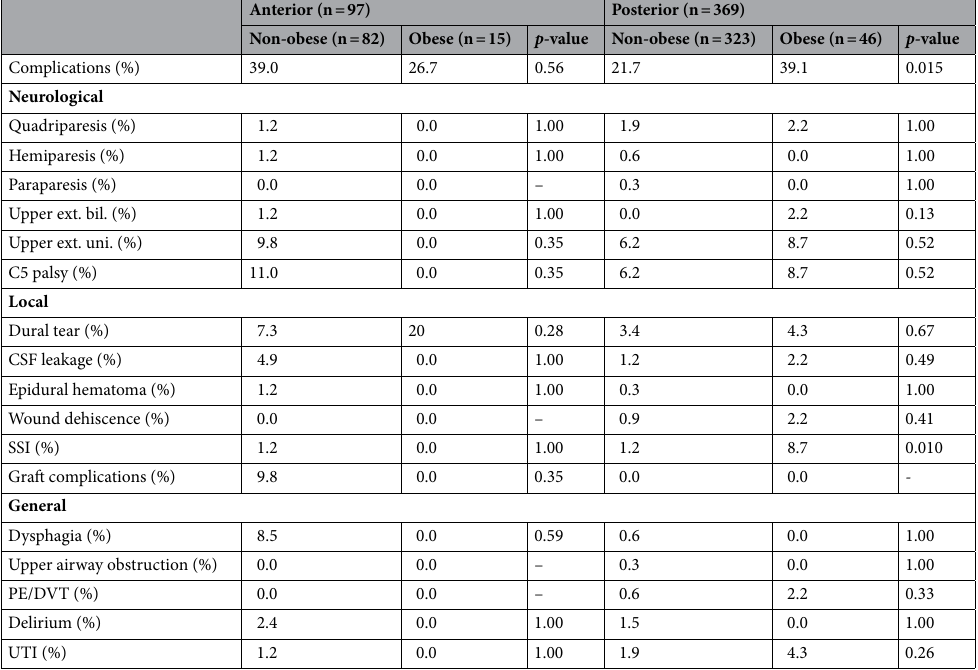
Table 6. Perioperative complications by each approach. Non-obese: BMI < 30.0 kg/m 2 ; Obese: BMI ≥ 30.0 kg/ m 2 ; BMI: body mass index; ex: extremity; bil: bilateral; uni: unilateral; CSF: cerebrospinal fluid; SSI: surgical site infection; PE: pulmonary embolism; DVT: deep venous thrombosis; UTI: urinary tract